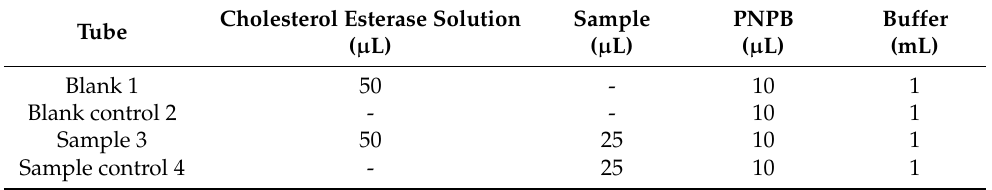
Table 6. The amount of additive agents for cholesterol esterase inhibitory activity